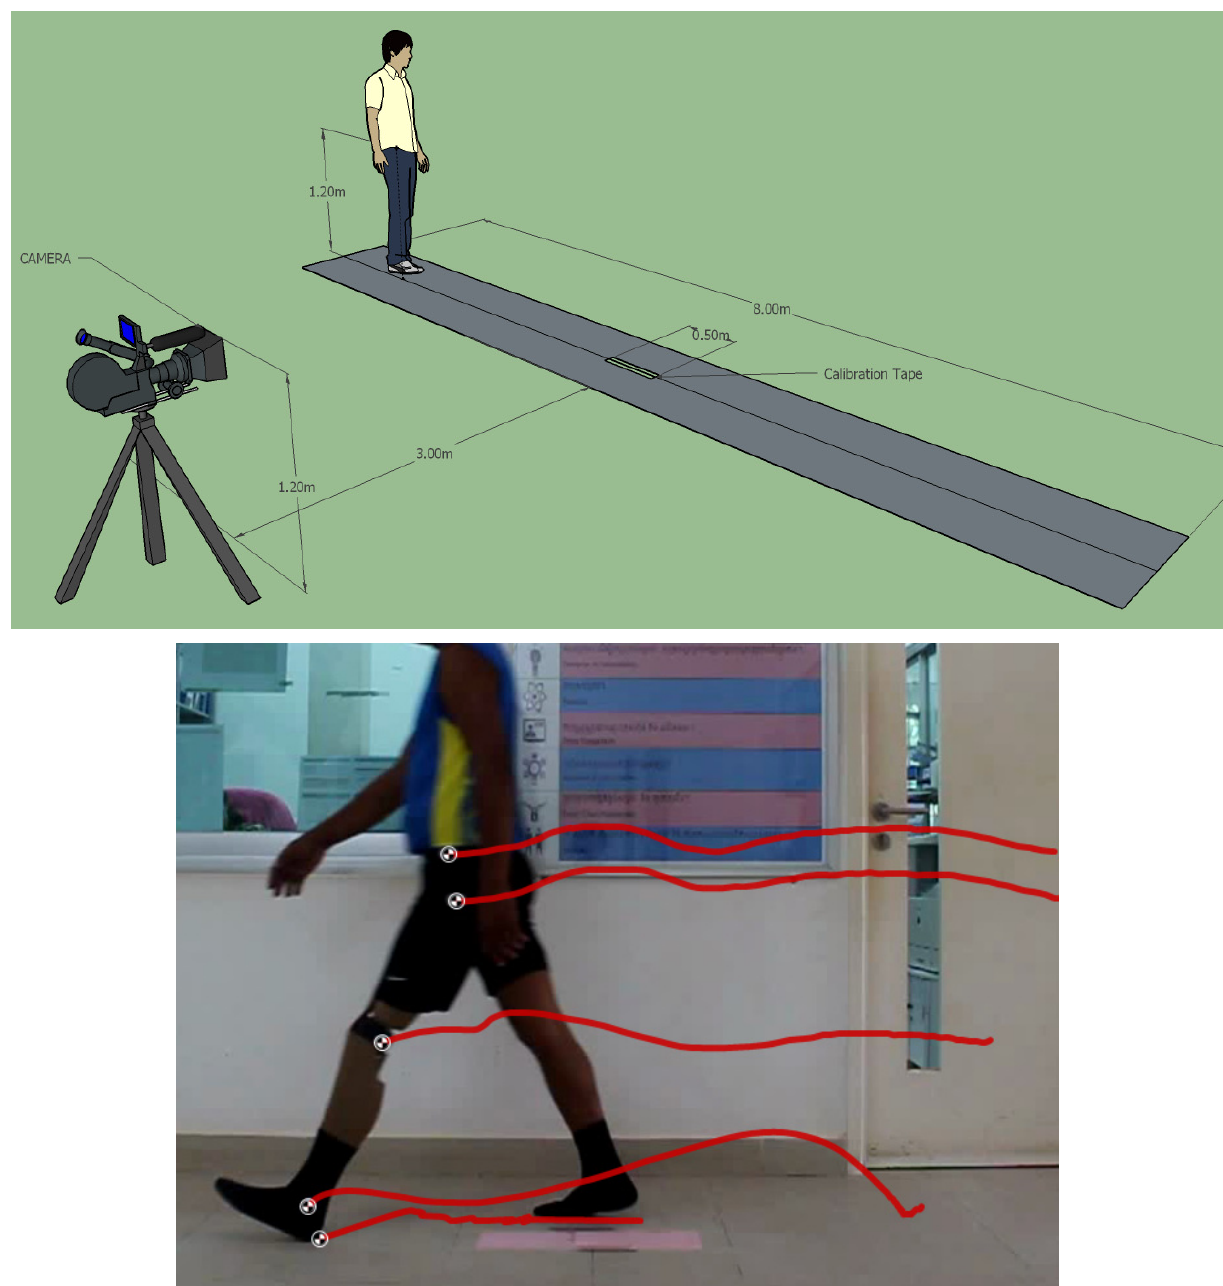
Figure 3. 2D video analysis set up ( top ) and Kinovea marker tracking ( bottom ). Secondary measures providing a gross characterization of gait included velocity, ca- dence, stride length and double support time. The additional analyzed gait parameters